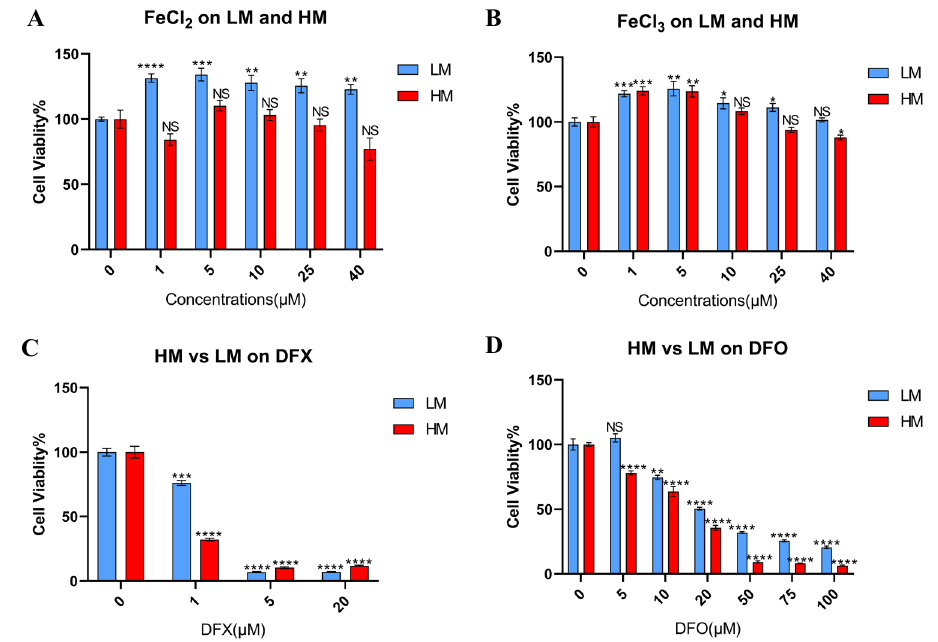
Figure 3. The tolerance of iron metabolic change differs between metastatic and primary sites in 4T1 cells. ( A , B ) Murine TNBC cells, 4T1–HM, and 4T1–LM cells were treated for 48 h with iron additional condition by FeCl 2 and FeCl 3 ( n = 6). ( C , D ) 4T1–HM and 4T1–LM were treated for 48 h with iron chelators. DFX and DFO were used ( n = 6). Cell viability was determined via Cell Proliferation Kit II (XTT). Cell viability in the absence of treatment was set at 100%. Treatment groups were compared with Control group, respectively. The Student’s t test with Welch’s correction was utilized to compare two groups, NS represented not significant, * p < 0.05, ** p < 0.01, *** p < 0.001, and **** p < 0.0001, and Data shown as the mean ± S. E. M.